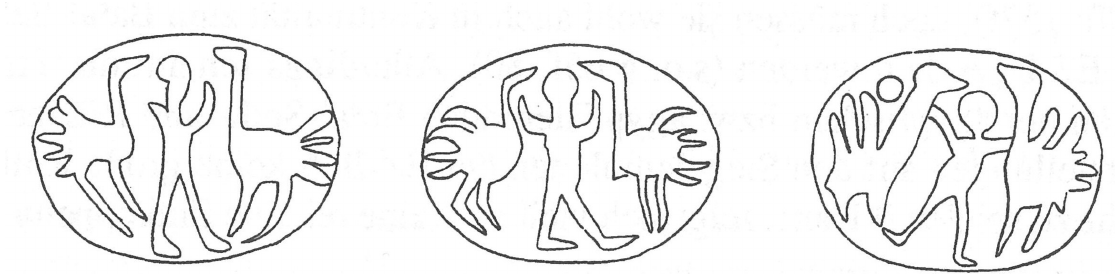
Figure 6 Seals (impressions) showing the “lord of the ostriches” (Tell el-Farah North, Gezer, Beth- Shemesh, Iron Age